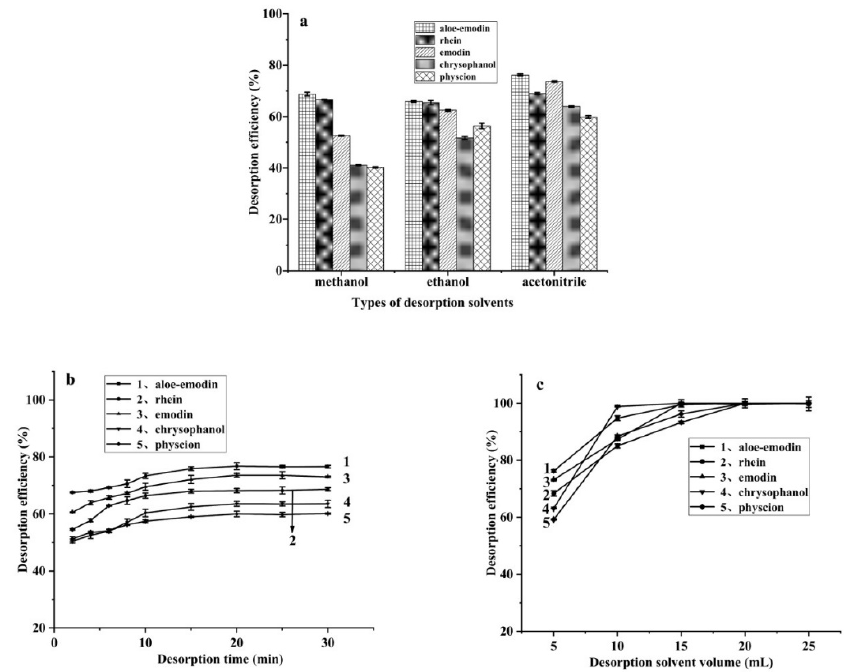
Figure 4. The effect of the type of desorption solvents ( a ), desorption time ( b ), and the volume of desorption ( c ). ( n = 3) Conditions: ( a ) Initial standard solution concentration, 10 mg/L each; methanol content, 50%; volume of standard solution, 5 mL; adsorption time, 10 min; HC-C18 (0.12 g/mL) (adsorption 3 times); volume of desorption solvent, 5 mL; desorption time, 30 min. ( b ) Initial standard solution concentration, 10 mg/L each; methanol content, 50%; volume of standard solution, 5 mL; adsorption time, 10 min; HC-C18 (0.12 g/mL) (adsorption 3 times); desorption solvent, acetonitrile; volume of desorption solvent, 5 mL. ( c ) Initial standard solution concentration, 10 mg/L; methanol content, 50%; volume of standard solution, 5 mL; adsorption time, 10 min; HC-C18 (0.12 g/mL) (adsorption 3 times); desorption solvent, acetonitrile; desorption time, 30